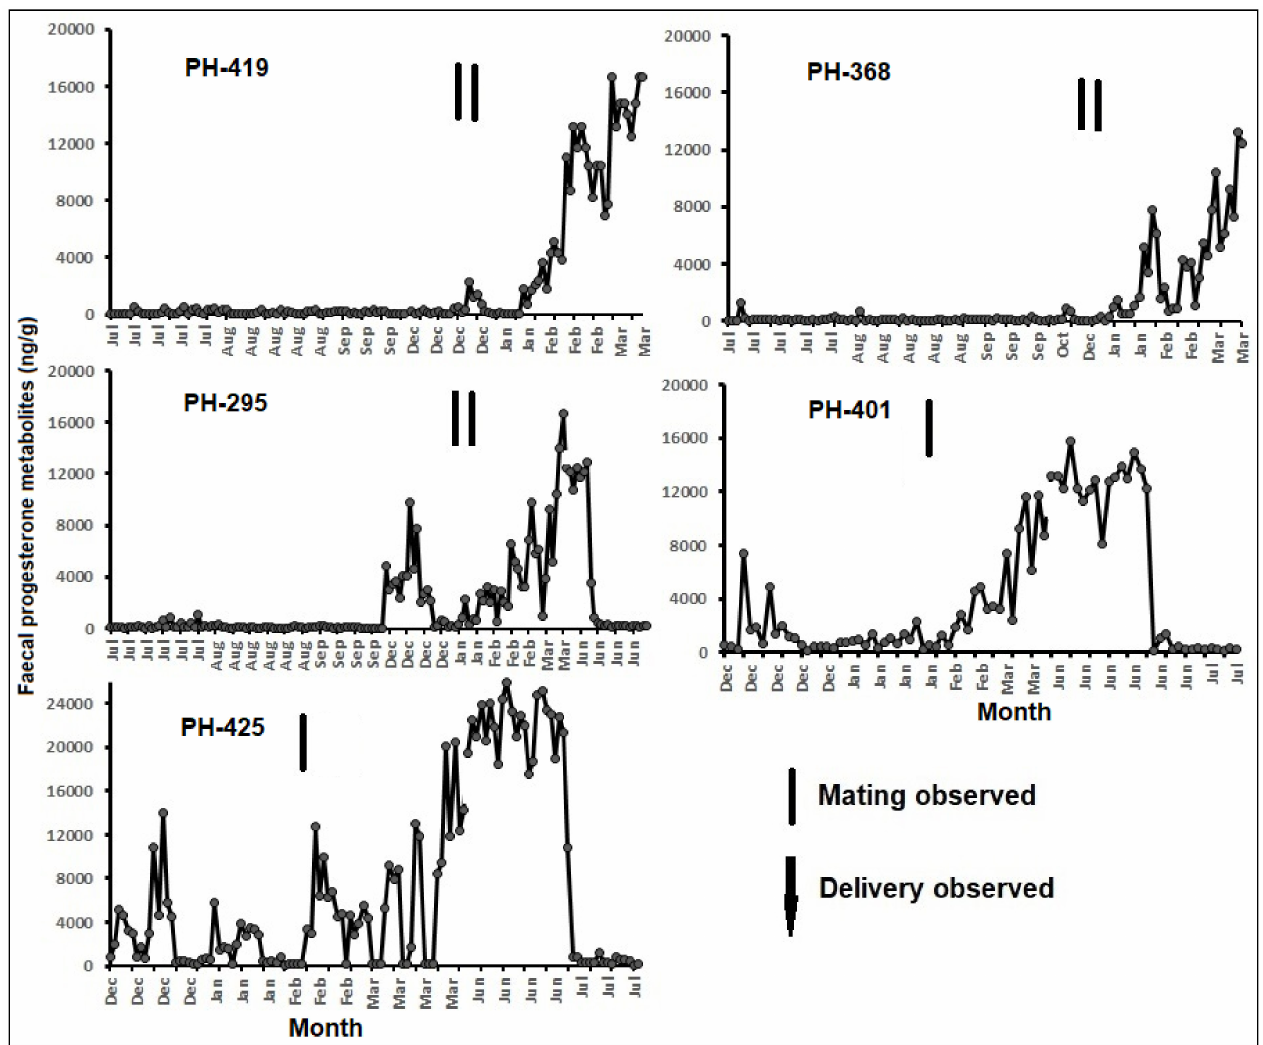
Figure 3. Fecal progesterone metabolite concentrations in five females monitored over 10 to 12 months at the Pygmy Hog Conservation Programme (PHCP), Guwahati (vertical bars—mating observed; down arrow—delivery of piglets observed). PH (Pygmy Hog)-419 could not be sampled before and after the delivery due to restriction in space, while PH (Pygmy Hog)-368 had died due to unknown